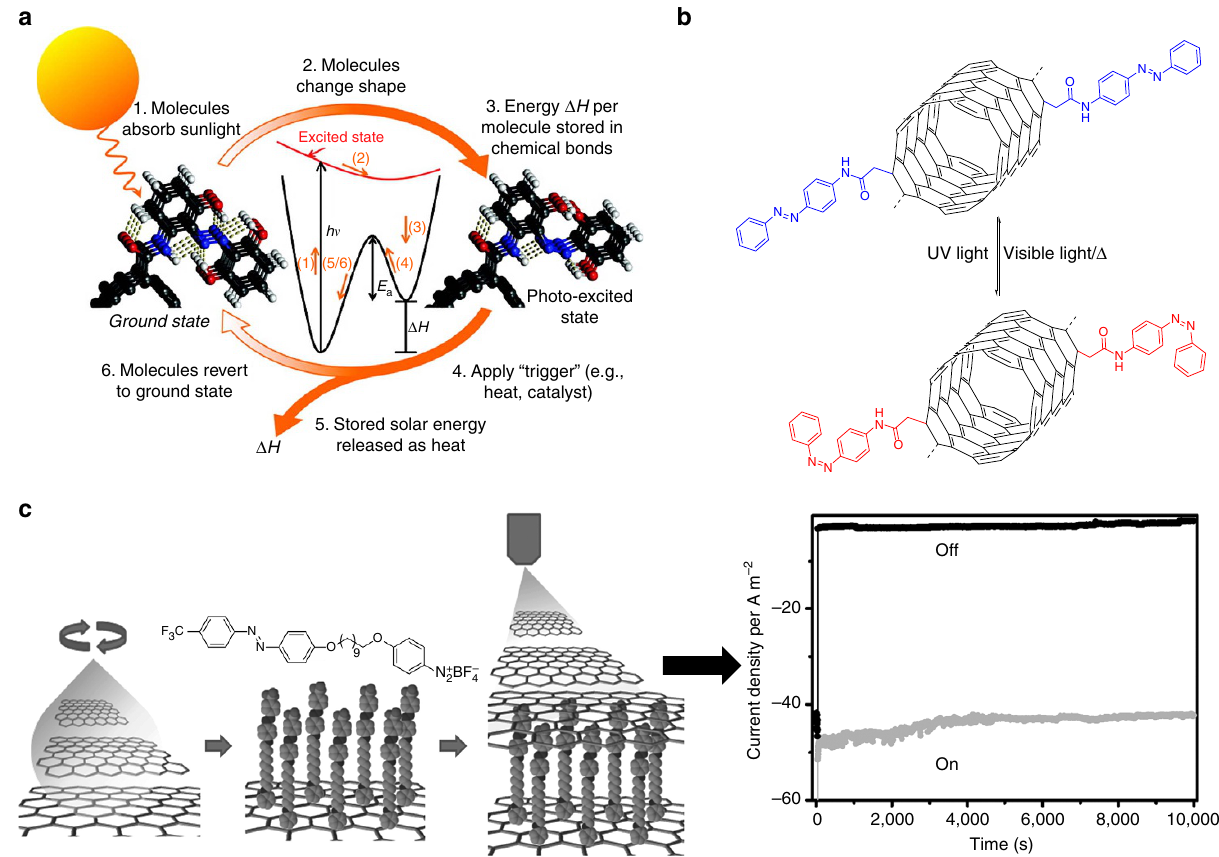
Figure 4 | Applications of photochromic carbon-based nanomaterials in solar thermal storage and memory devices. ( a ) Mechanism of solar thermal fuels based on azobenzene covalently linked to CNTs. Reproduced from ref. 104 (Copyright 2011 American Chemical Society). ( b ) Scheme for photochemical and photochemical/thermal cycling of azobenzene covalently attached to CNTs used for solar thermal fuels. Figure 4b is drawn according to ref. 20 (Copyright 2014 Nature Publishing Group). ( c ) Voltage-controlled non-volatile molecular memory devices by using an azobenzene monolayer as the active layer sandwiched between two rGO electrodes via a solution process, and memory-retention performances of the ON state and the OFF state. Reproduced from ref. 108 (Copyright 2013 John Wiley & Sons,